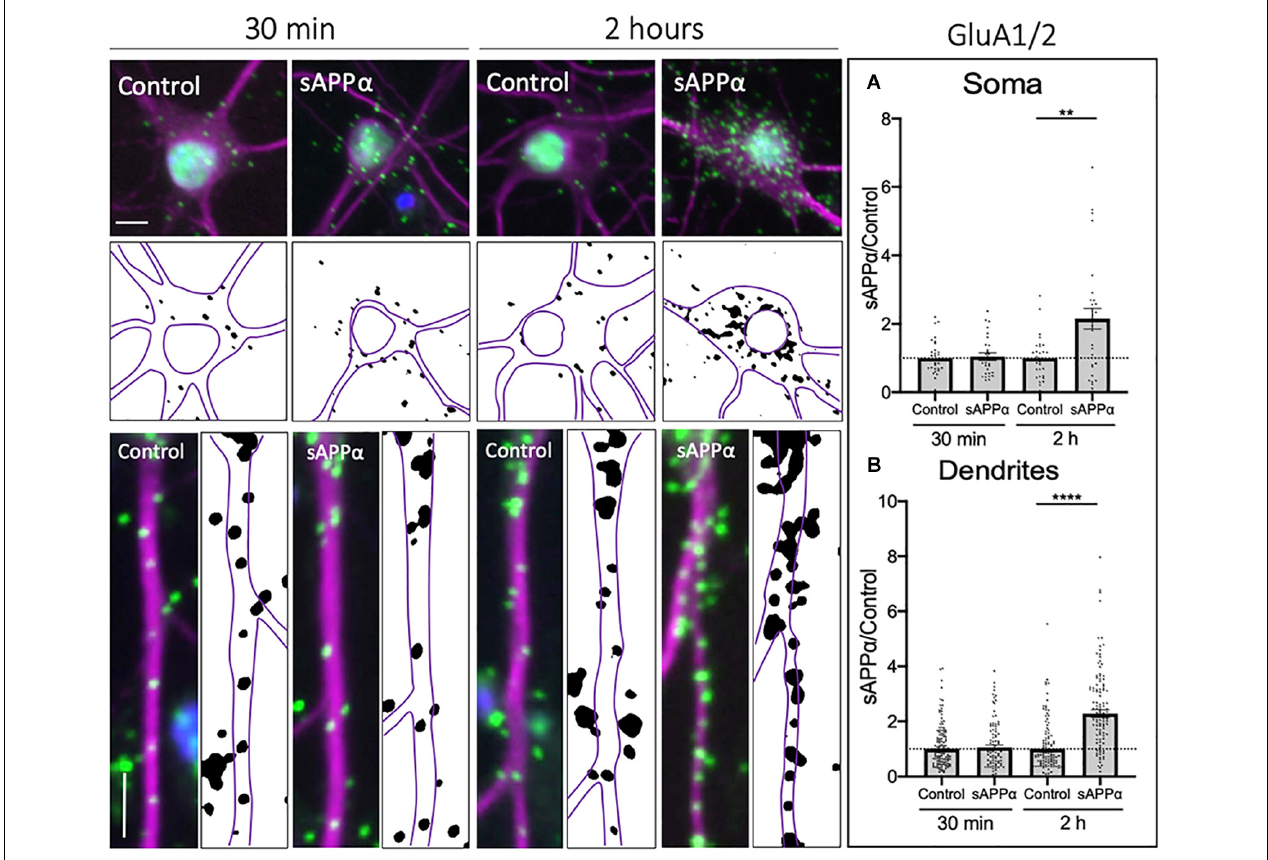
FIGURE 6 | Secreted amyloid precursor protein-alpha enhances cell-surface GluA1/2-containing AMPARs. Representative images showing cell-surface GluA1/2 levels in the soma (top panels) and dendrites (lower panels) from 30 min (left) and 2 h (right) controls and sAPP α treated conditions. Average data showing 1 nM sAPP α promotes an increase in the (A) soma ( n = 28–31 cells) and (B) dendrites ( n = 98–142) following 2 h- but not 30 min treatments. All data are expressed relative to control, as mean ± SEM from 3 experiments. Normality was detected by D’Agostino and Pearson omnibus normality tests and significance was assessed by student’s t -test, ** p ≤ 0.001, **** p ≤ 0.0001. Representative images show neuronal soma (upper panels) and dendrites (lower panels; MAP2, (cid:4) ; GluA1/2, (cid:4) ; DAPI, (cid:4) ). Scale bars = 10 µ